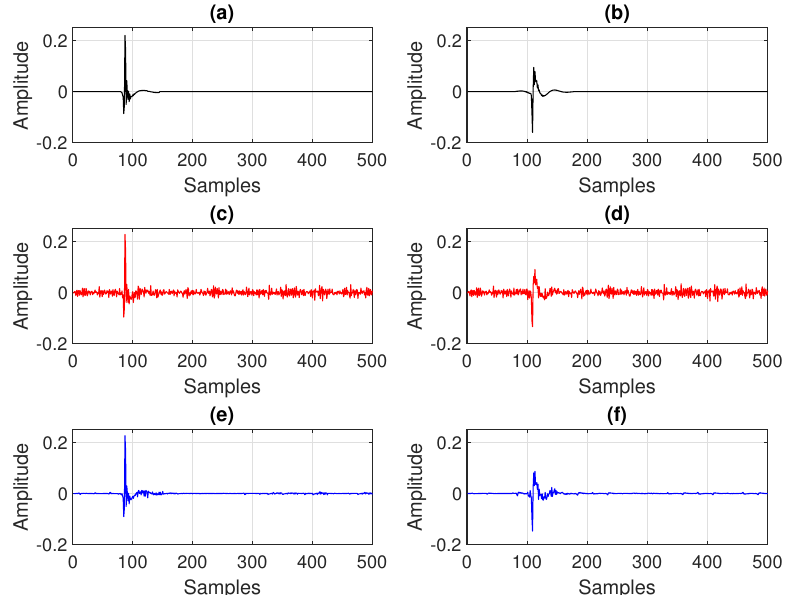
Figure 6. Performance of the conventional Wiener filter (WF) and the iterative Wiener filter (IWF) using P = 2, for the identification of the network echo paths from Figure 1a,b. ( a ) The true network impulse response from Figure 1a; ( b ) the true network impulse response from Figure 1b; ( c ) estimated impulse response with the conventional WF, corresponding to Figure 1a; ( d ) estimated impulse response with the conventional WF, corresponding to Figure 1b; ( e ) estimated impulse response with the IWF, corresponding to Figure 1a; and ( f ) estimated impulse response with the IWF, corresponding to Figure 1b. Other conditions are the same as in Figure 5.